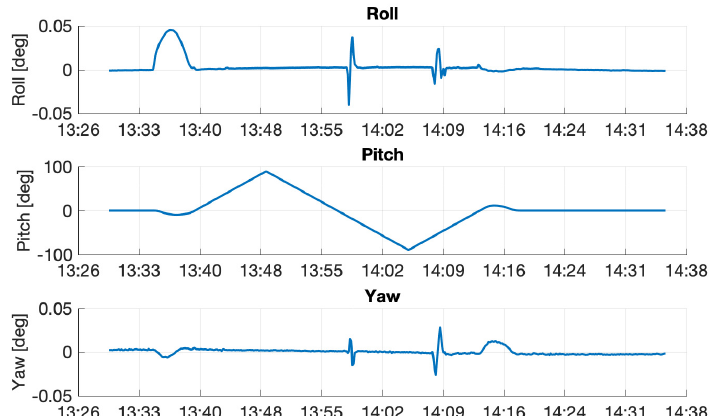
Figure 7. Roll, pitch, and yaw data for the NOAA-20 pitch maneuver.